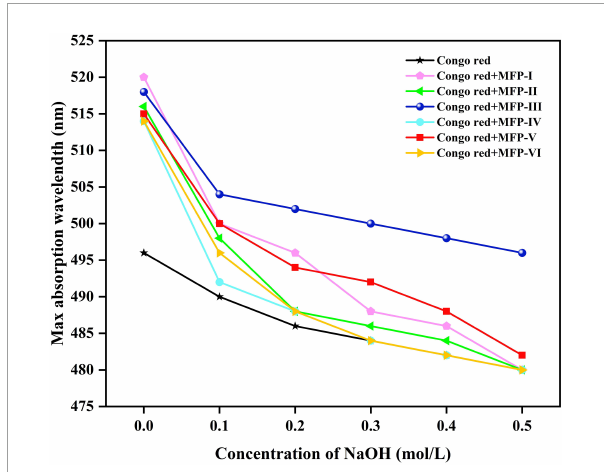
FIGURE8 Analysis of spiral-curl transformation of mulberry polysaccharides in different NaOH